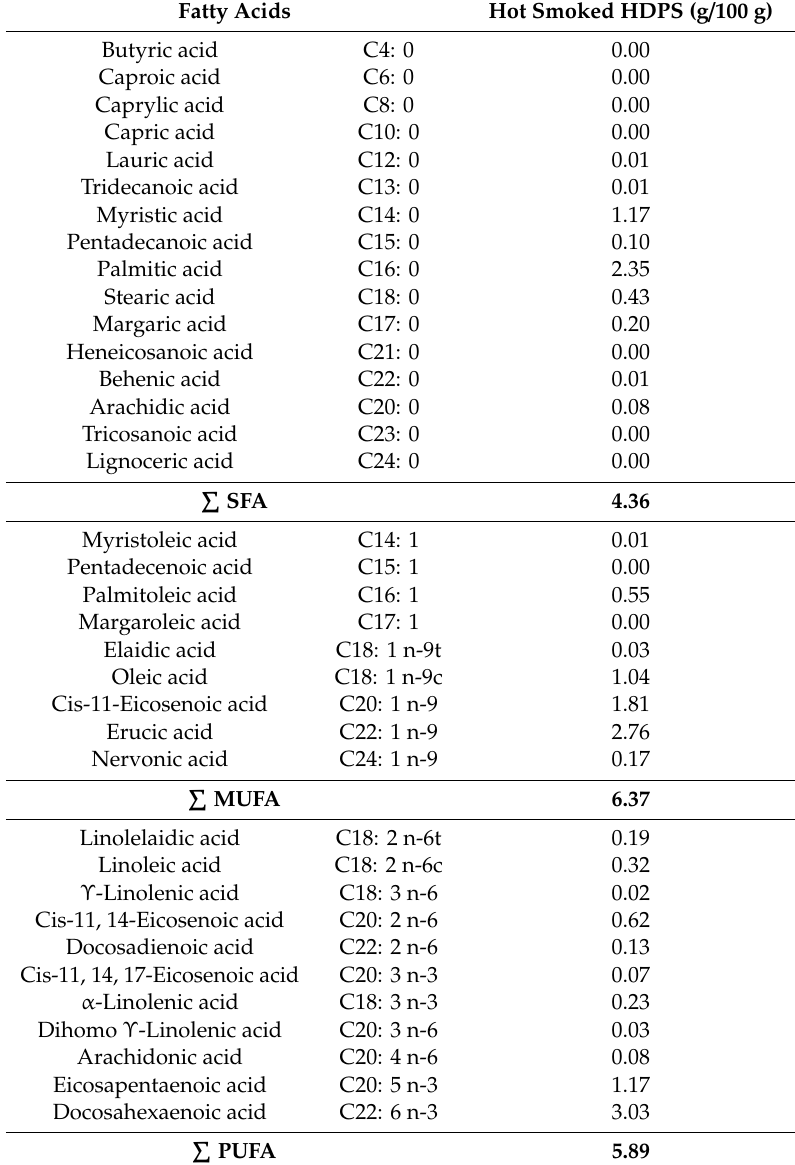
Table 3. Fatty acid profile of hot smoked